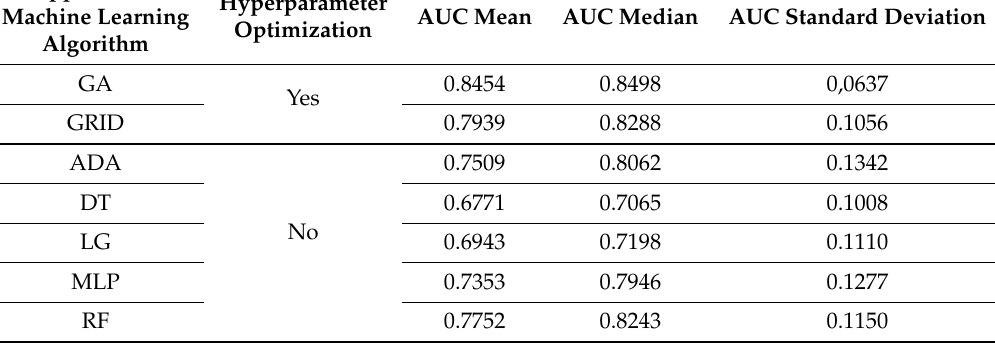
Table 5. AUC for 50 weeks.